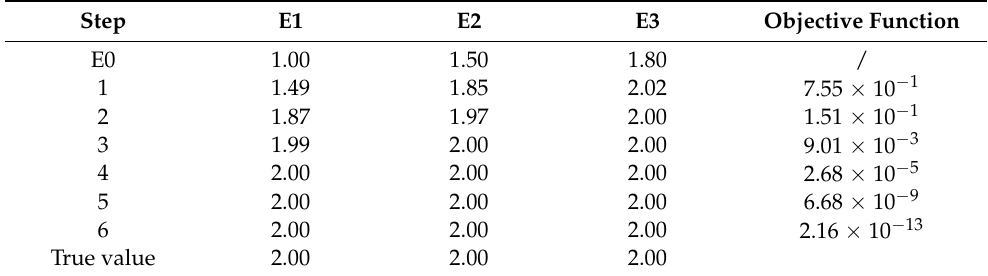
Table 3. Iteration process (unit: 10 8 N/m 2 ).